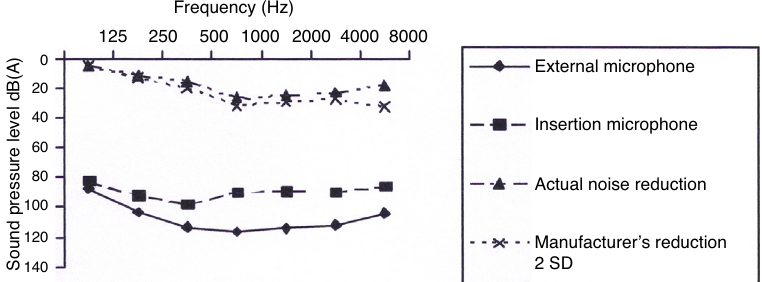
Figure 3 Values of the measurement by frequency (L EQ [equivalent level/dBA]) performed by insertion and external microphone. Values of actual noise reduction and noise reduction suggested by the manufacturer, after discounting the values of the standard deviation (SD), multiplied by two.